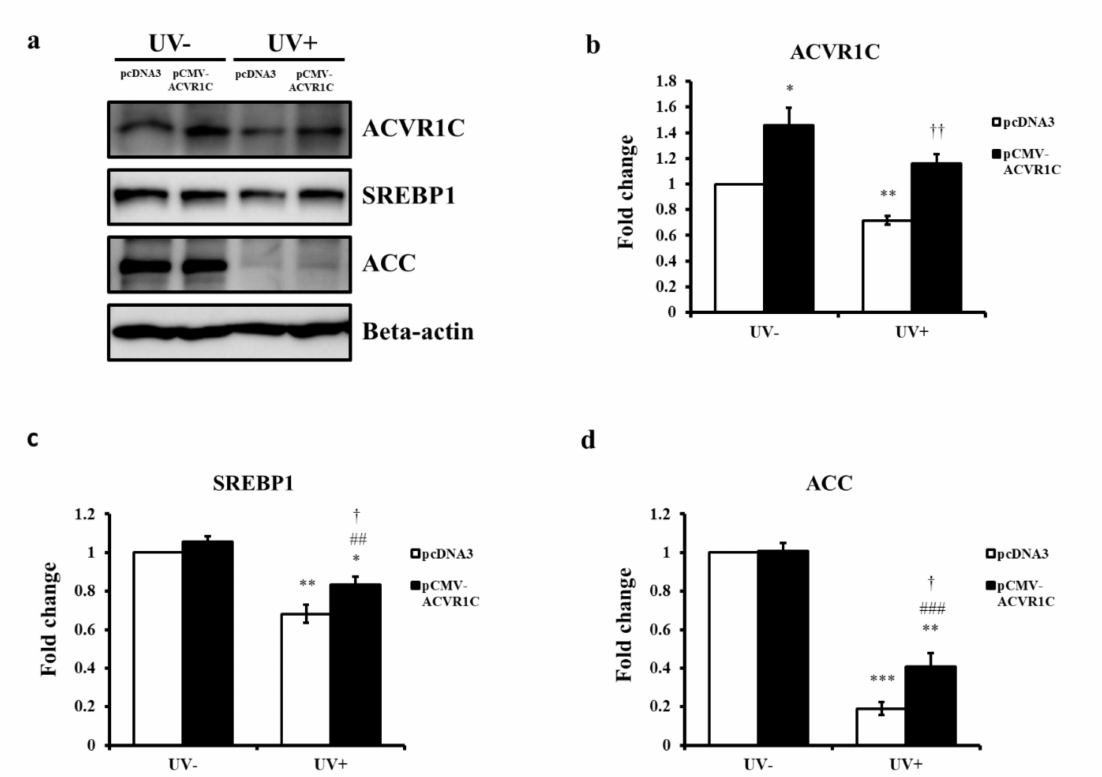
Figure 4. ACVR1C overexpression ameliorated UV-induced decreases in SREBP1 and ACC protein expression in primary NHEK. Primary NHEK were transfected with an expression vector containing the ACVR1C gene and then irradiated with UV (75 mJ/cm 2 ). ( a ) ACVR1C, SREBP1, and ACC protein levels were measured by Western blotting at 24 h after UV irradiation and ( b–d ) the protein levels were quantified using ImageJ. β -actin was used as a loading control (n = 4). * p < 0.05, ** p < 0.01, and *** p < 0.001 vs. non-irradiated pcDNA3; ## p < 0.01 and ### p < 0.001 vs. non-UV-irradiated pCMV-ACVR1C; † p < 0.05 and †† p < 0.01 vs. UV-irradiated